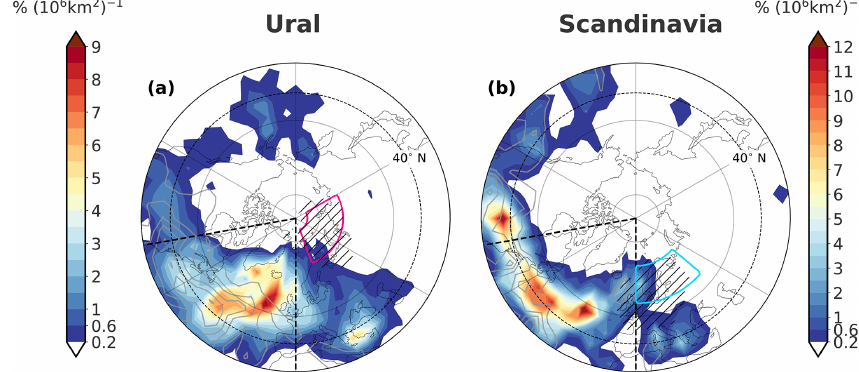
Figure 10. Spatial distribution of the locations of maximum heating for the trajectories within the heating regime initialized from Ural (a) and Scandinavian (b) blocks. Shading shows the density of trajectories at the time of maximum 6-hourly heating, defined as the percentage of the total number of heated trajectories per unit area (here 5 ◦ × 5 ◦ ). The gray contours show the locations of the trajectories 6d prior to arrival into the blocking region (normalized area-weighted density, shown every 1%(10 6 km 2 ) − 1 , starting from 1%(10 6 km 2 ) − 1 ). The magenta box in panel (a) and the cyan box in panel (b) show the Ural and Scandinavian sector, respectively, where the hatched regions indicate the main backward trajectory starting locations within the blocks (normalized area-weighted density > 5%(10 6 km 2 ) − 1 ). The main heating domain is denoted by the black dashed lines, and the black dashed circle shows the latitude line at 40 ◦ N.